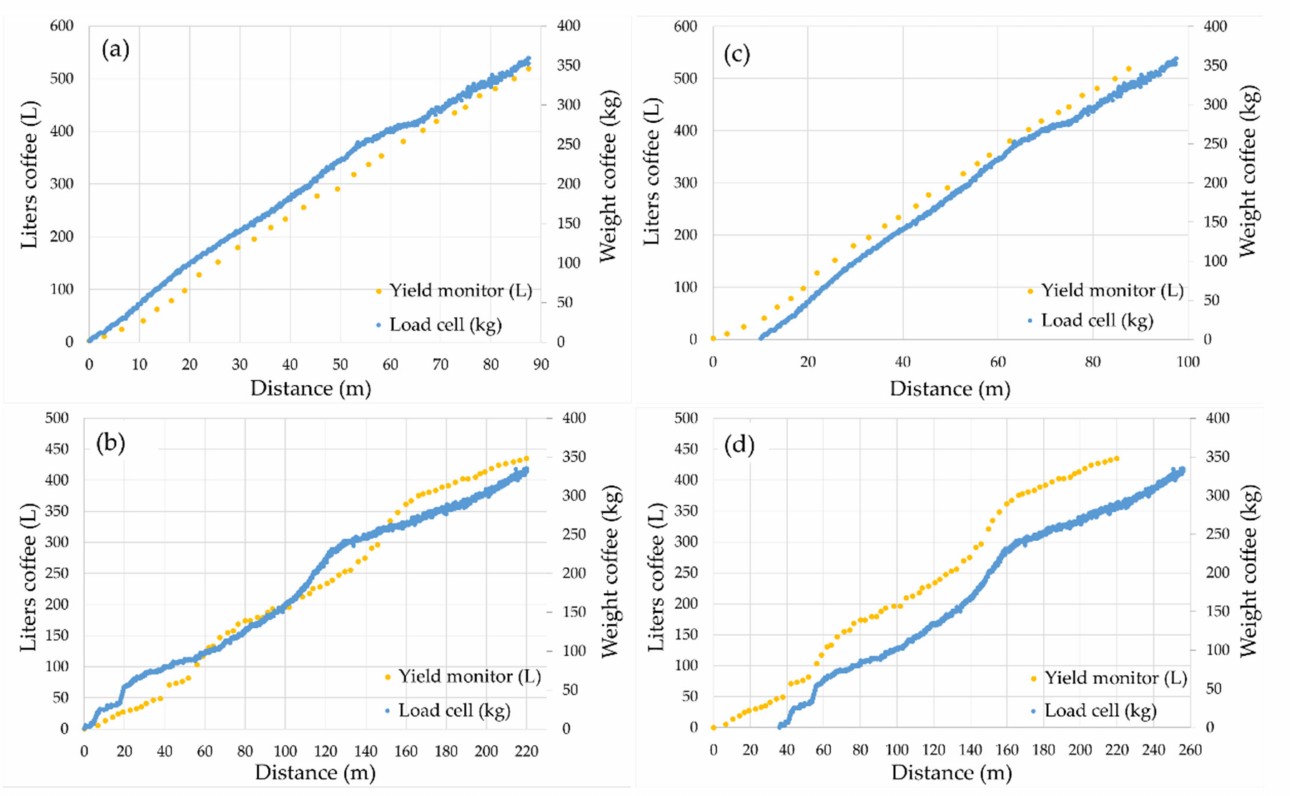
Figure 4. Distribution of coffee fruit harvest data obtained by the yield monitor and by load cells in the ( a ) high- and ( b ) low-yield rows, and with the addition of offset in the distance to the load cells wagon in the ( c ) high- and ( d ) low-yield